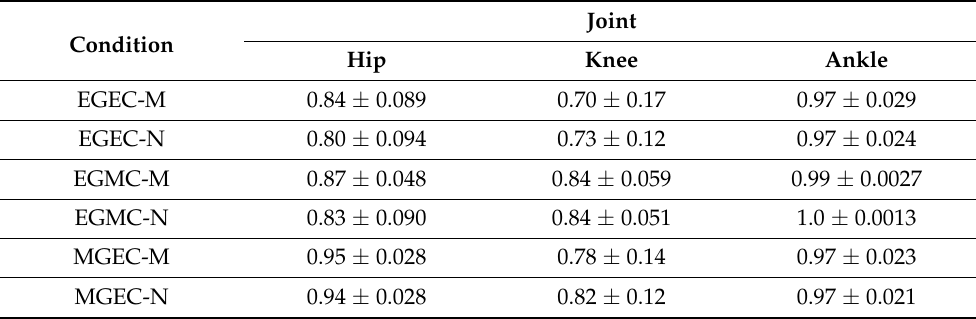
Table 5. RMSE of joint torques averaged across all the trials and subjects for all the con- ditions: i) estimated GRF and COP with musculoskeletal model (EGEC-M), ii) estimated GRF and COP with neuromusculoskeletal model (EGEC-N), iii) estimated GRF and measured COP with musculoskeletal model (EGMC-M), iv) estimated GRF and measured COP with neuromusculoskeletal model (EGMC-N), v) measured GRF and estimated COP with musculoskeletal model (MGEC-M), vi) measured GRF and estimated COP with neuromusculoskeletal model (MGEC-N). The unit for RMSE is Nm/kg.